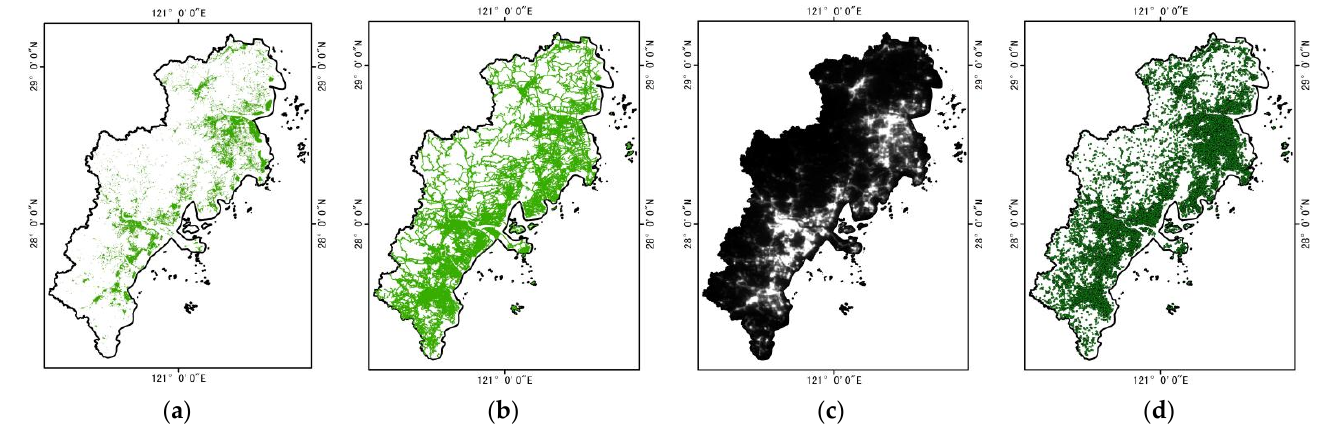
Figure 2. Data presentation: ( a ) Artificial surface of Globeland30 in 2020; ( b ) OSM road network of 2022; ( c ) NPP/VIIRS nighttime light data of 2020; ( d ) POIs of AMAP in 2020.